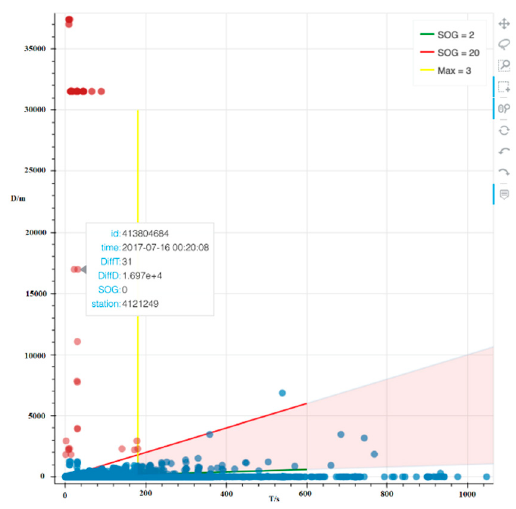
Figure 9. Information